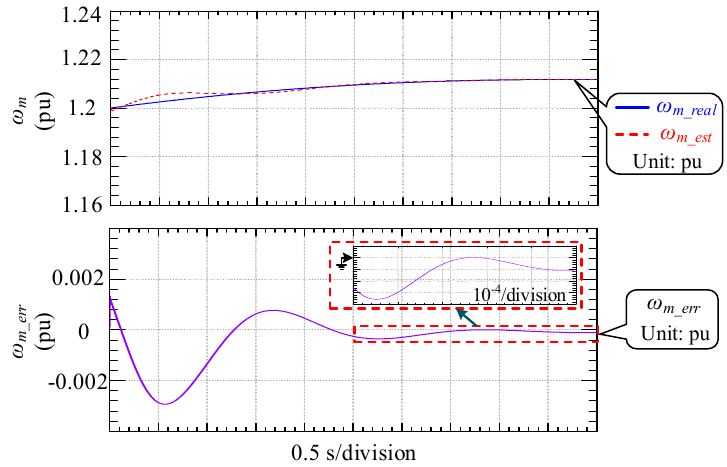
Figure 9. Real and estimated rotor angular speeds and the estimation error by using the EKF algorithm